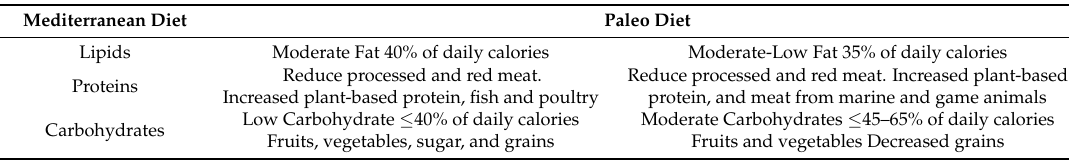
Table 2. Comparison of Mediterranean and Paleo